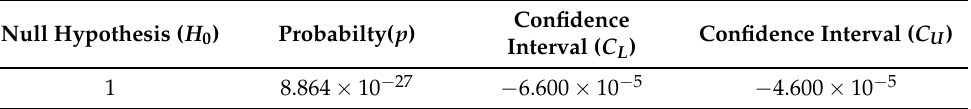
Table 6. Two-sample t -test on real-parts of MammoWave’s S 21 data. Null Hypothesis ( H 0 )